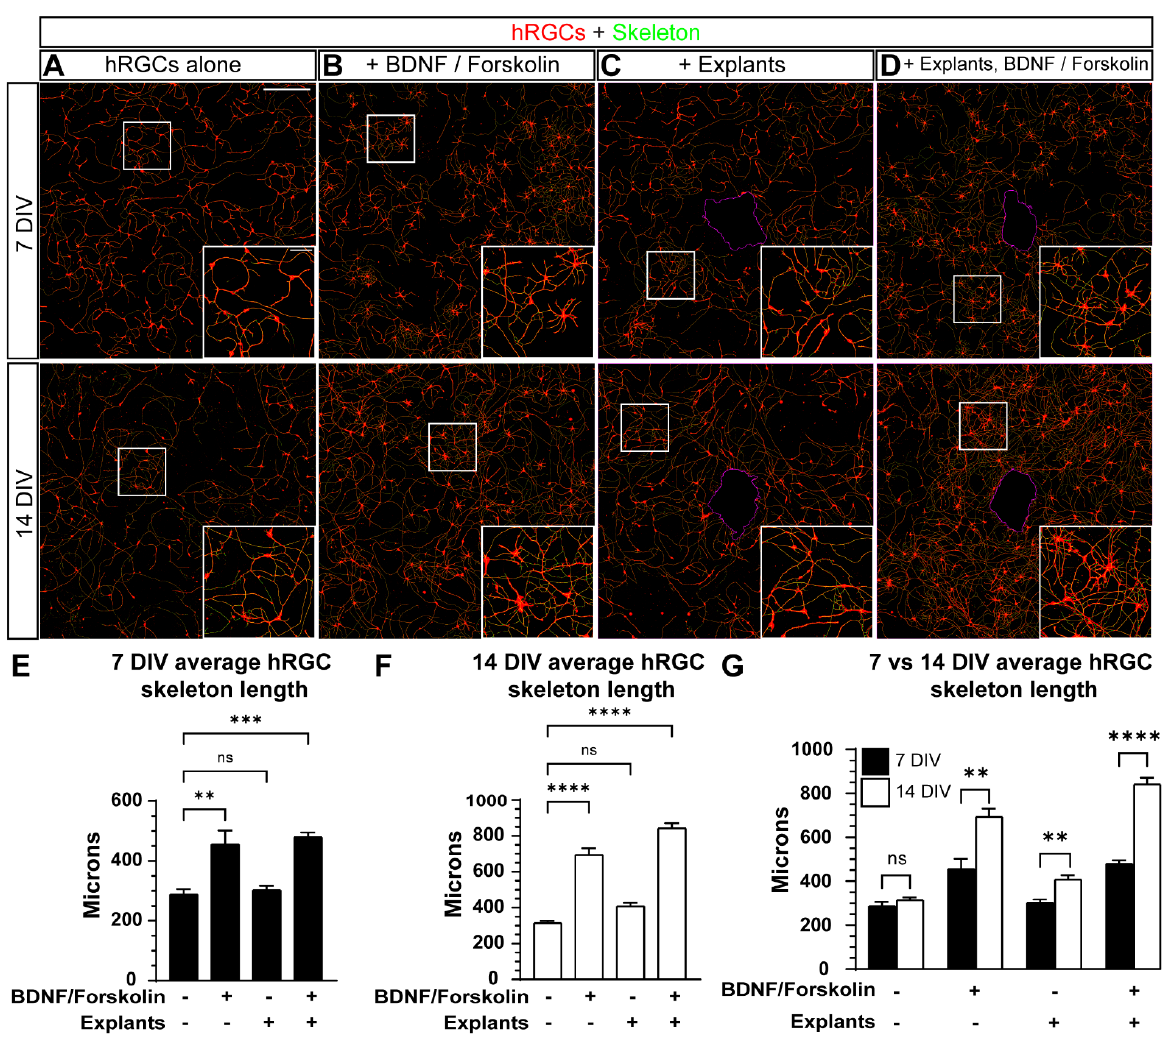
Figure 5. The effect of adult mouse retina explants and a combination of BDNF and forskolin on hRGC neurite outgrowth. ( A – D ) Representative images of 7 DIV (top panels) and 14 DIV (bottom panels) hRGCs overlayed with their generated skeletons. hRGCs alone ( A ), with BDNF/forskolin ( B ), cocultured with adult explants ( C ) and cocultured with adult explants and BDNF/forskolin. A magenta outline of the explant perimeter is depicted in ( C , D ). Insets depict magnified views of the boxes. ( E – G ) A quantification of the average length of skeletonized hRGCs at 7 DIV ( E ), 14 DIV ( F ) and a comparison between 7 and 14 DIV ( G ). At 7 and 14 DIV, both a combination of BDNF and forskolin without and with the presence of adult explants, increases the average hRGC skeleton length (7 DIV: p = 0.0025 and p = 0.0006, respectively, 14 DIV: p < 0.0001). A comparison between the average hRGC skeleton length between 7 and 14 DIV shows that without the addition of BDNF and forskolin or the presence of explants, the average hRGC skeleton length does not significantly differ ( p = 0.2421). Conversely, supplementation with BDNF and Forskolin, the presence of explants as well as a combination of supplementation with explants, increases the average hRGC skeleton length at 14 DIV compared to 7DIV ( p = 0.0098, p = 0.0067 and p < 0.0001 respectively). Scale bars: A top panel= 500 µ m, A top panel inset = 100 µ m. Data are shown as mean ± SEM, ** indicates p < 0.01, *** indicates p < 0.001, **** indicates p < 0.0001, ns = no significance. Statistical significance was tested using an ordinary one-way ANOVA, Dunnett’s post hoc test ( E,F) and unpaired t test ( G ). 7DIV hRGCs alone: N = 3 coverslips, n = 3 2.9 × 2.9 mm images, 7DIV + BDNF, forskolin: N = 3, n = 3, 7DIV + explants: N = 4, n = 3–4, 7DIV + explants + BDNF, forskolin: N = 4, n = 3–5, 14DIV hRGCs alone: N = 4, n = 3, 14DIV + BDNF, forskolin: N = 4, n = 3, 14DIV + explants: N = 3, n = 3–4, 14DIV + explants + BDNF, forskolin: N = 4, n =